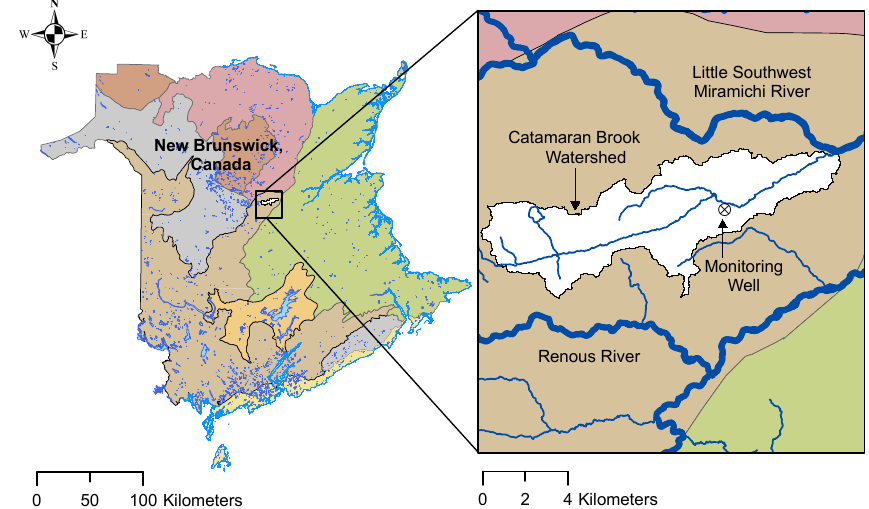
Fig. 1. Location of the Catamaran Brook watershed in New Brunswick, Canada. Catamaran Brook is located in the Valley Lowlands eco- region of New Brunswick (data from NBADW,